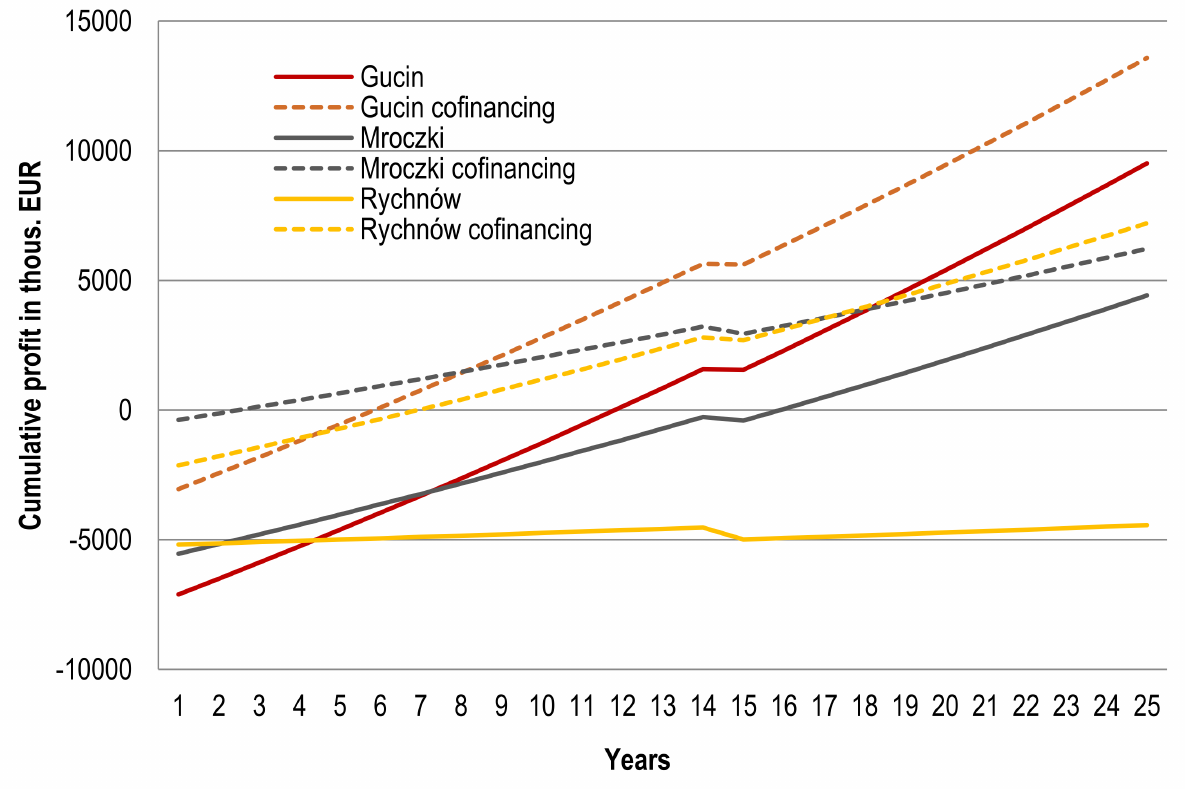
Figure 6. Cumulative profit in a 25 years period for the three analysed locations. The NPV and IRR values were calculated for three periods: 15, 20, and 25 years. In addition, the variant with project co-financing (52.7%—supporting the production and distribution of energy from renewable sources) was considered. Detailed calculations are given in Table